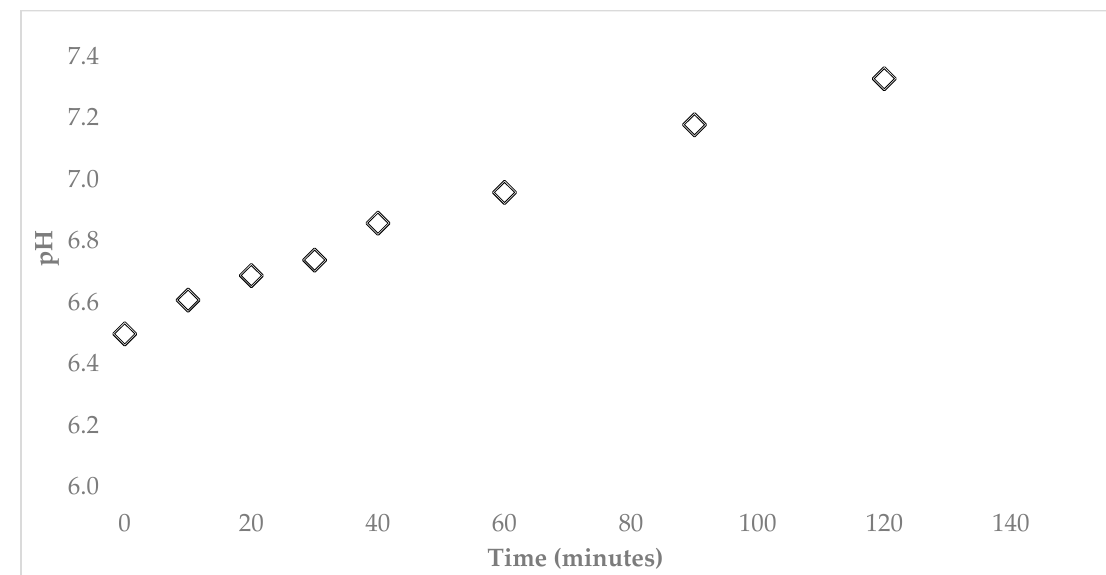
Figure 14. Results of pH of water during kinetic experiment of iron and manganese onto zeolite Y. Initial Fe = 1.15 mg L − 1 ; Initial Mn = 1.61 mg L − 1 ; adsorbent dose = 2 g L − 1 , T = 25 °C; water pH = 6.5.